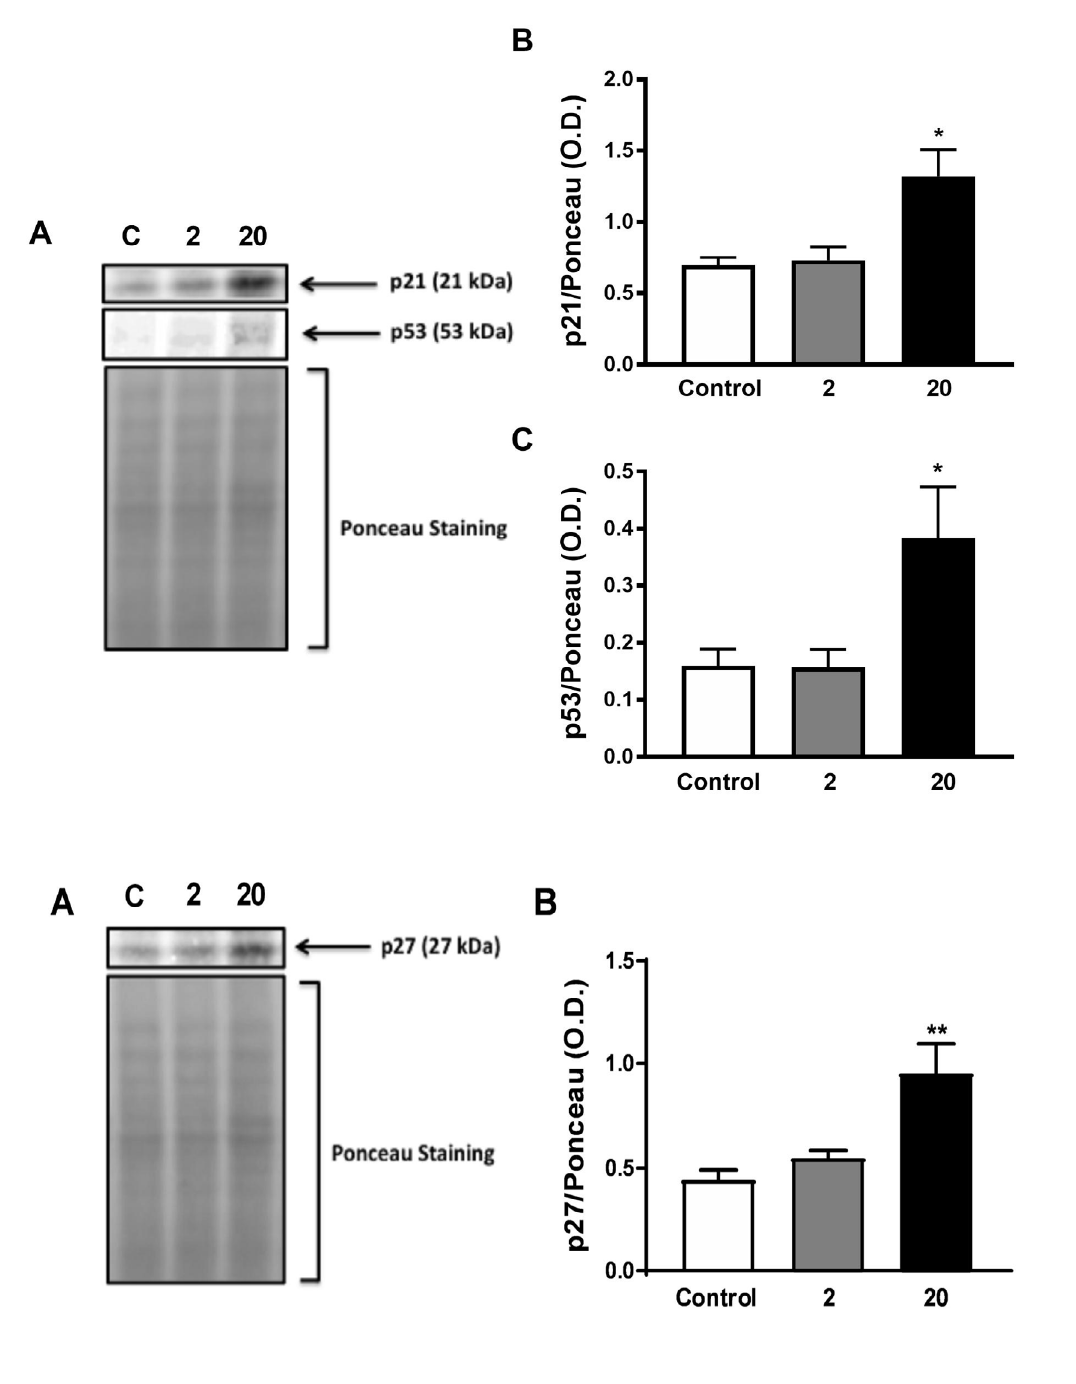
Figure 9. Protein expression analysis of p53, p21 and p27 in cultured astrocytes by western blotting. Astrocytes were incubated in the absence (control) or presence of β-micrustoxin (2, 20 nM) for 2 h. (A) Representative images of immunobloting. (B) and (C) Quantification by Ponceau analysis of p21, p27 and p53. One-way ANOVA; Bonferroni post-hoc test: *p < 0.05, **p < 0.01 vs. control. N =